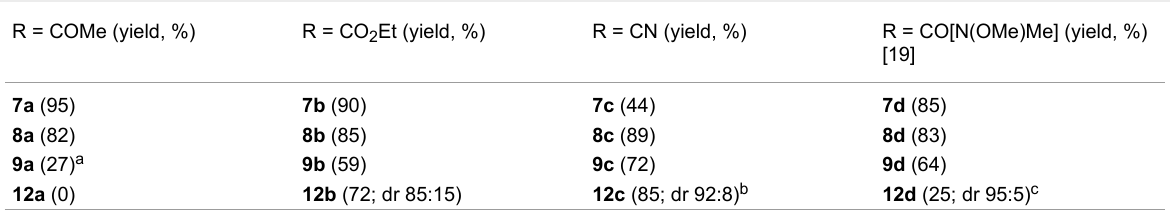
Table 1: Yields for compounds shown in Scheme 1 and Scheme 2. R = COMe (yield,